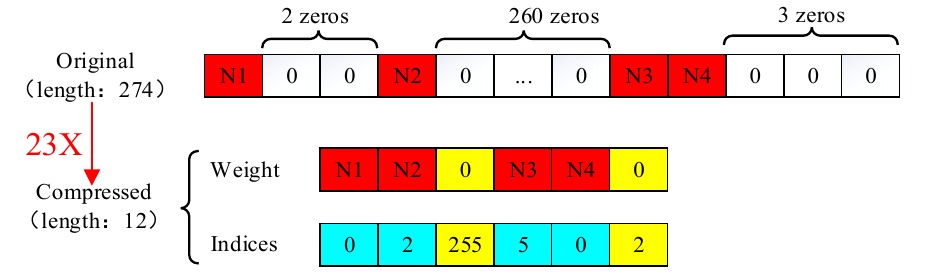
Figure 7. Sparse representation of fully connected layers.